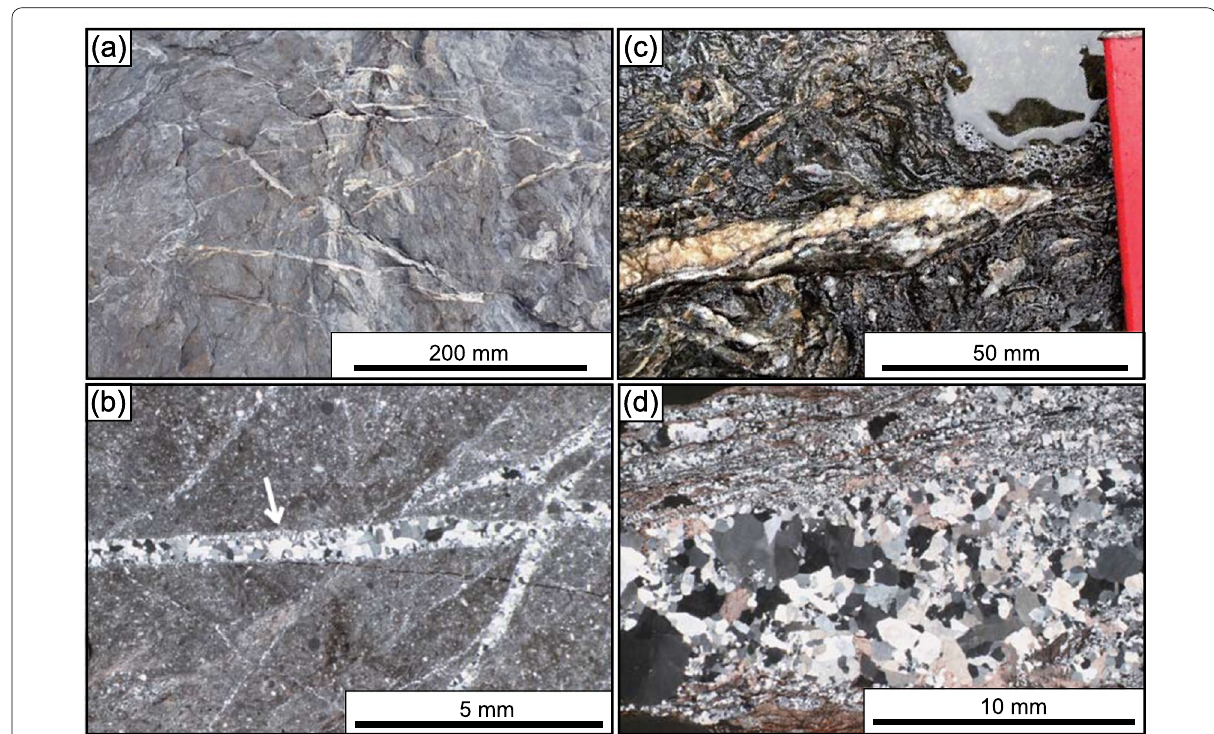
Fig. 4 Photographs of outcrops and photomicrographs of thin sections of quartz veins under crossed Nicol. a Shows the quartz veins in the grid F and an arrow in b shows the veins near the a . Both a and b formed during a single seismic event. c , d Show the quartz vein formed during multiple seismic events whose location is indicated as a solid circle in Fig.